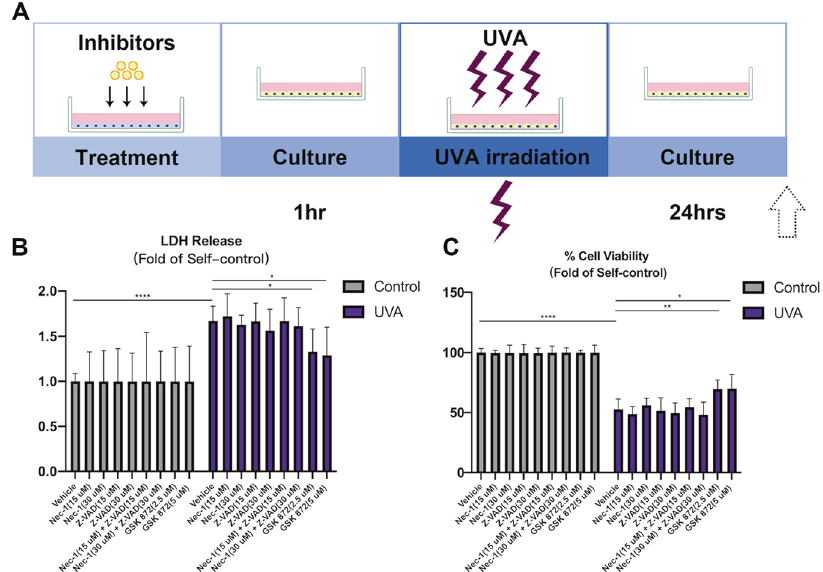
Fig. 3 GSK 872, the inhibitor of RIPK3 reduces cell death in pHCECs. A Flow chart of pHCECs treatment and UVA irradiation model. B, C LDH and Cell viability of pHCECs treated with vehicle DMSO (30 μ M), RIPK1 inhibitor Nec-1 (15 and 30 μ M), CASPASE inhibitor Z-VAD (15 and 30 μ M), combination of Nec-1 and Z-VAD (15 and 30 μ M), RIPK3 inhibitor GSK 872 (2.5 and 5 μ M) after non-UVA and UVA irradiation ( n = 6 per group). Statistical signi fi cance was analyzed with the unpaired Student ’ s t -test . ** P < 0.01 , *** P < 0.001 , **** P < 0.0001 . All values are expressed as mean ±